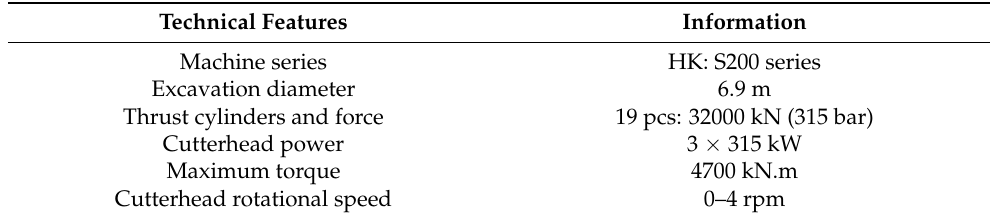
Figure 1. Isfahan metro lines (after Google Imagery @2022 CNES/Airbus, Maxar Technologies, Map Data @2022). Table 1. Technical features of the EPBM used in the Isfahan